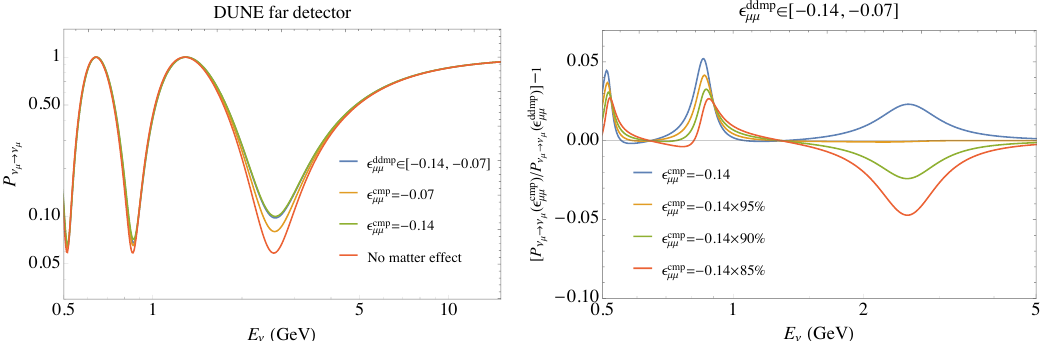
Figure 4 . Left: survival probability of a muon neutrino beam after traveling through the earth in a DUNE-like setup as discussed in the caption of (cid:12)gure 3. We consider a gauged L e (cid:0) L (cid:22) model and simpli(cid:12)ed two (cid:13)avor oscillations (cid:23) (cid:22) ! (cid:23) (cid:28) . Right: a closer comparison between a depth dependent matter potentials de(cid:12)ned in eq. (3.3) and several constant matter potentials.